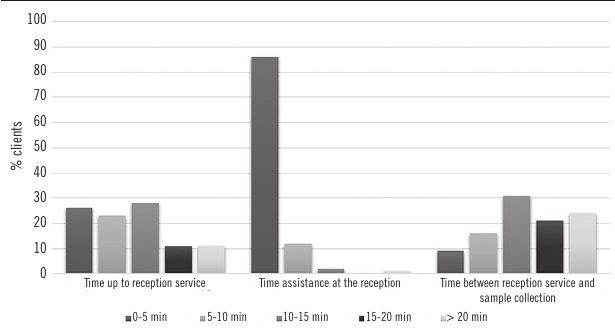
figurE – Distribution of clients according to perceived service time